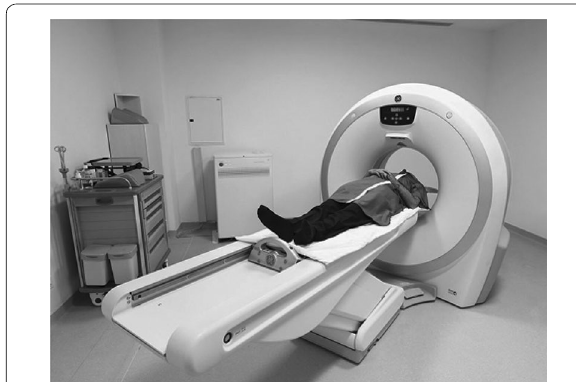
Fig. 1 Example of magnetic resonance imaging (MRI) scanner setup in an authorized private medical hospital producing high-quality images of human brain. The motorized bed is moved inside the oval shaped scanner, and the head is scanned